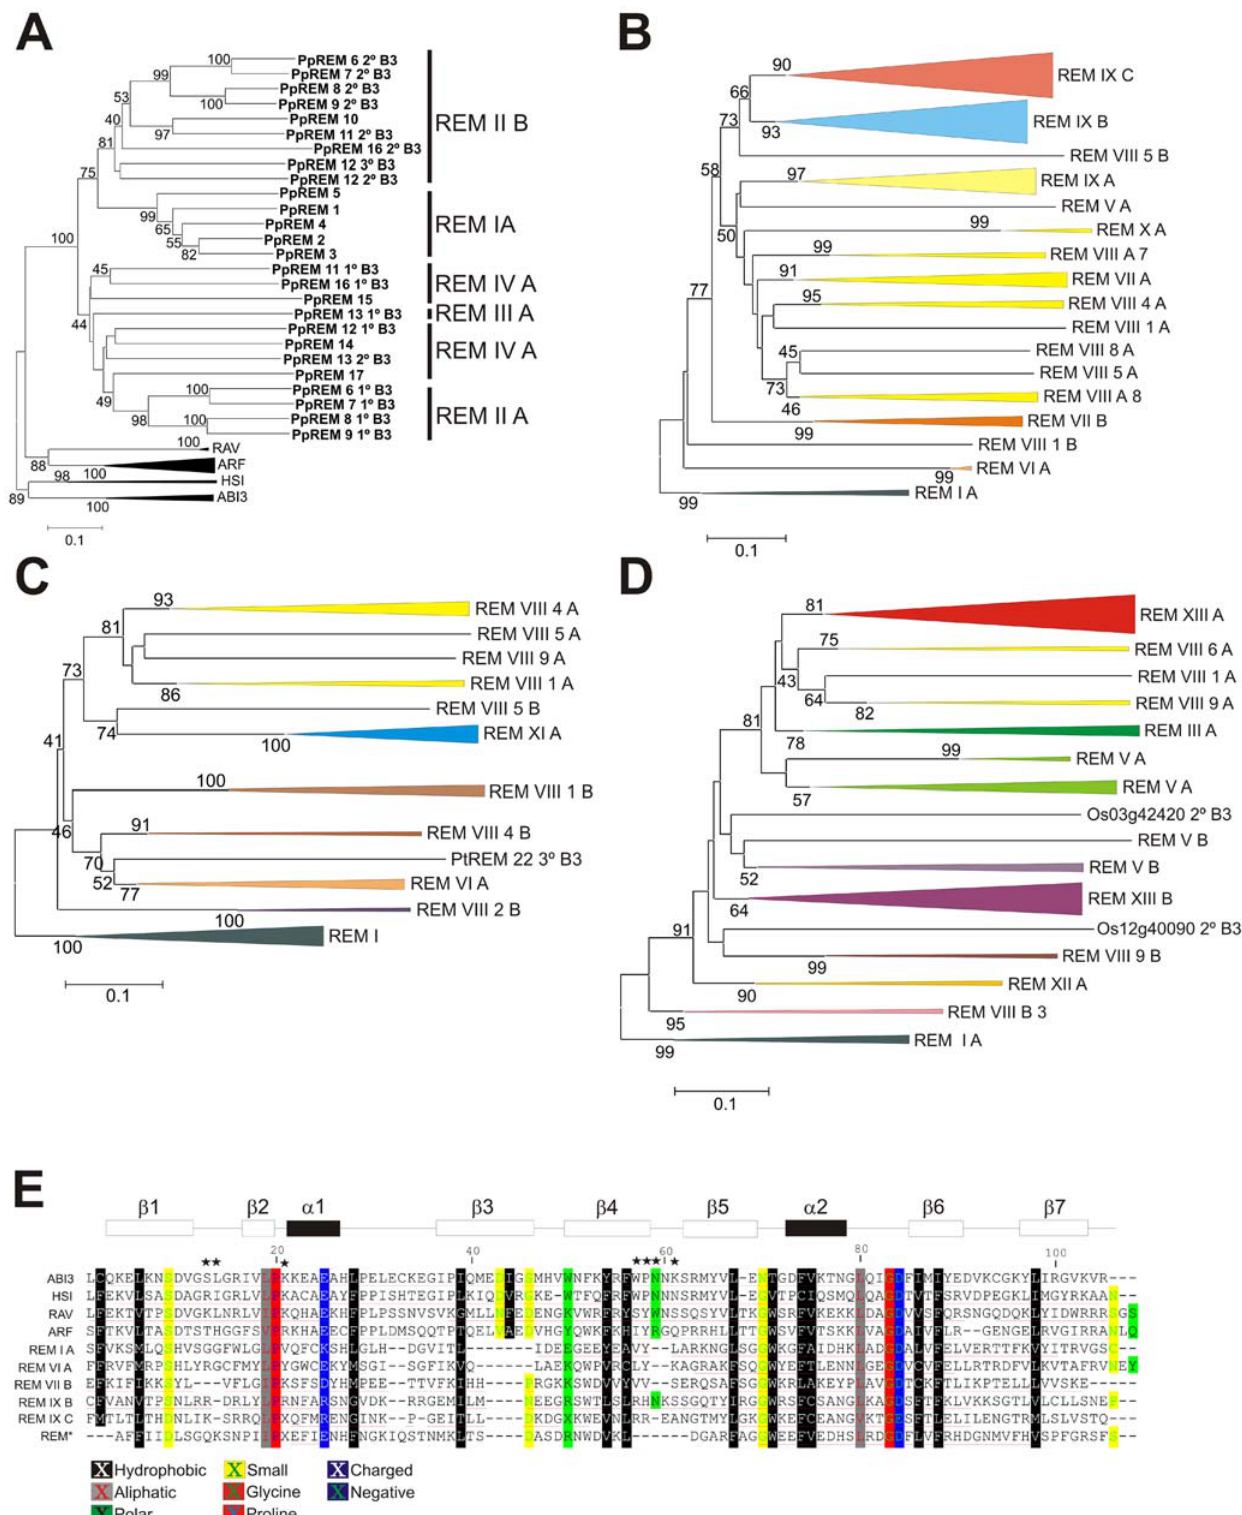
Figure 2. Phylogeny of B3 domains sequences. A , Rooted in ABI3/HSI Neighbor-joining tree of all five B3 families based on the B3 domain amino acid sequences of moss. B , Rooted in REM I class Neighbor-joining tree of all B3 domains members of REM family from Arabidopsis. C , Rooted in REM I class Neighbor-joining tree of all B3 domains member of REM family from poplar. D , Rooted in REM I class Neighbor-joining tree of all B3 domain member of REM family from rice. A , B , C and D - bootstrap values from 1,000 replicates. The scale bar represents a 0.1 estimated aminoacid substitution per residue. Bootstrap values . 40 are shown. The color chosen for each group of homologous is used to indicate the B3 domain types in